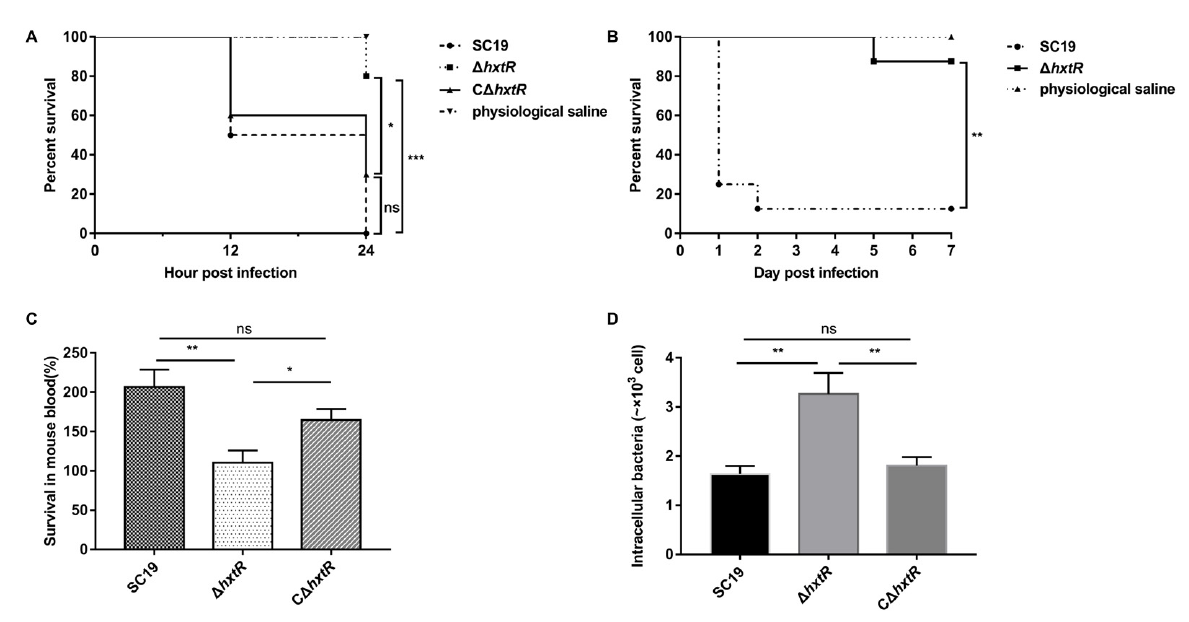
Figure 3. Virulence characterization of Δ hxtR , C Δ hxtR, and SC19 strains. ( A ) G. mellonella larvae infection assay; 20 µL of bacterial cells (approximately 3 × 10 6 CFU) of Δ hxtR , C Δ hxtR , and SC19 strains at the mid-log phase were used to inject larva from the left posterior proleg. Each group contained 10 larvae. The survival was recorded at 12 and 24 hpi and statistically analyzed using the log-rank (Mantel–Cox) test. * indicates p < 0.05, and *** indicates p < 0.001. ( B ) Mouse infection assay; 500 µL of bacterial cells (8.5 × 10 8 CFU) of Δ hxtR and SC19 strains at the mid-log phase were used to intraperitoneally inject mice. Each group contained 8 mice. The survival was recorded every 24 h post infection and statistically analyzed using the log-rank (Mantel–Cox) test. ** indicates p < 0.01. ( C ) Whole blood killing assay. Cells of Δ hxtR , C Δ hxtR, and SC19 strains at the mid-log phase were mixed with freshly prepared anticoagulated mouse blood, followed by incubation at 37 °C for 30 min. The mixture was then plated on TSA plates for viable bacteria enumeration. The survival was calculated as (CFU recovered/CFU in original inoculum) × 100% and statistically analyzed using the Student’s t -test. ns indicates p > 0.05, * indicates p < 0.05, and ** indicates p < 0.01. ( D ) Macrophage phagocytosis assay. Cells of Δ hxtR , C Δ hxtR, and SC19 strains were mixed with Raw264.7 macrophage cells with an MOI of 10:1, followed by incubation at 37 °C for 30 min. The cells were treated with ampicillin (50 µg/mL) to remove unphagocytized bacteria. The cells were then lysed, and the phagocytized bacteria were isolated and enumerated by plating on TSA plates. Statistical significances were determined by using the Student’s t -test. ns indicates p > 0.05, and ** indicates p < 0.01.